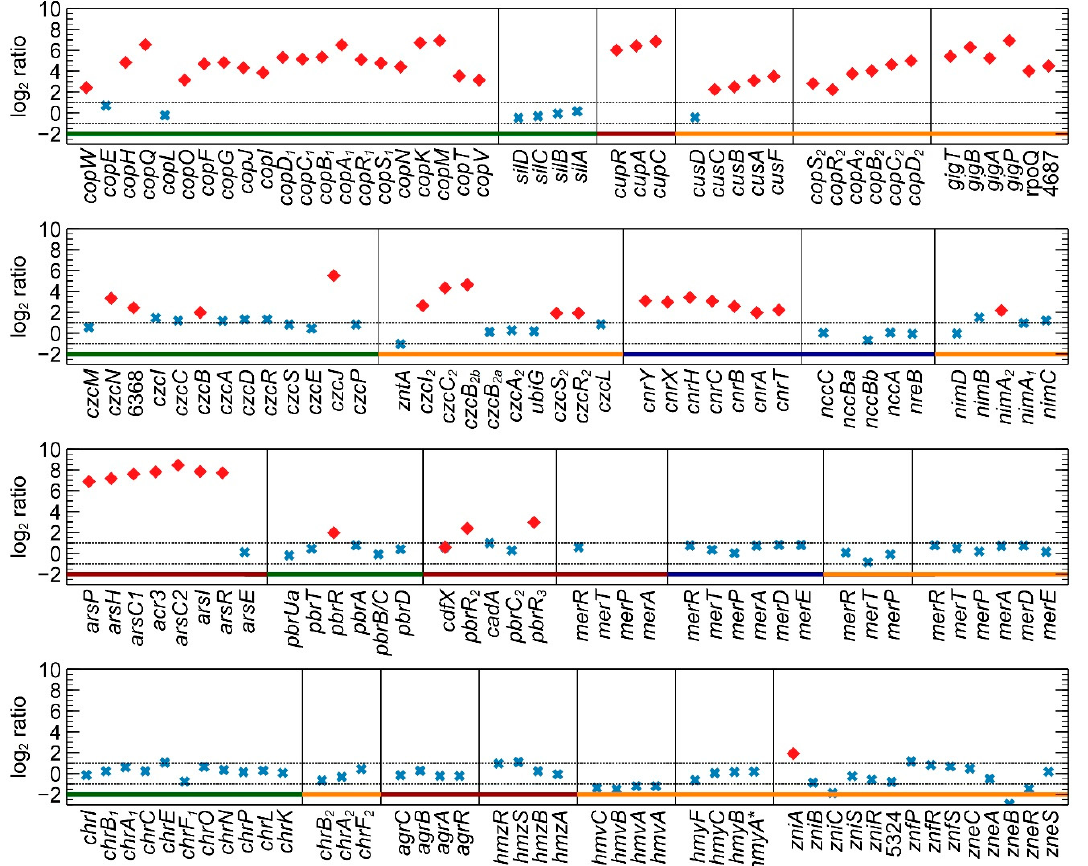
Figure 1. Differential gene expression of metal resistance genes from C. metallidurans CH34 exposed for 10 min to 400 µM Cu 2+ . Significant (red diamond; p < 0.05) and non-significant (blue cross) log 2 ratios are shown for known metal resistance genes located on the chromosome (red line under graph), chromid (orange), pMOL28 (blue), and pMOL30 (green). Dotted lines correspond to − 1 and 1, respectively.